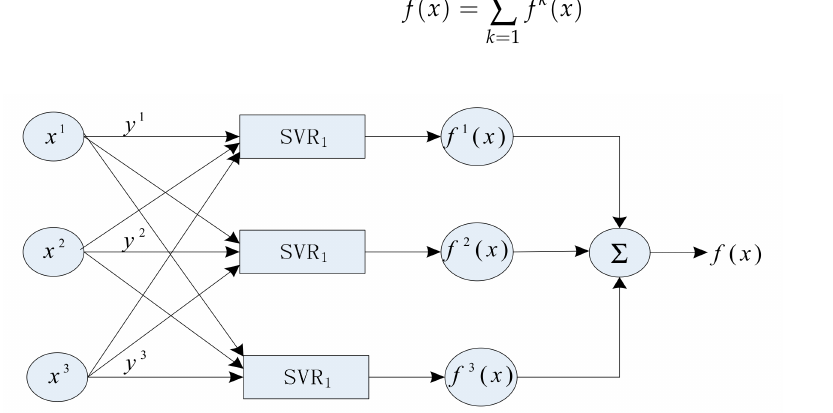
Figure 4. Multi-output support vector regression model of three dimensional electric field